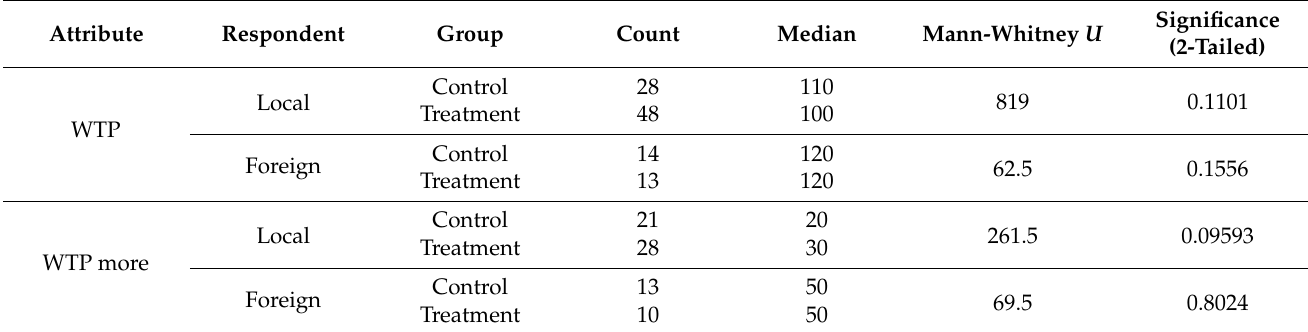
Table 6. Mann–Whitney U tests for WTP between control and treatment groups.